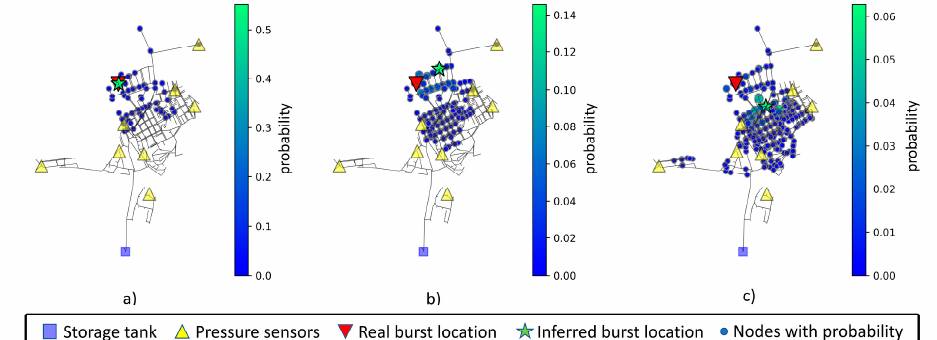
Figure 10. Network prediction areas for node 20, considering ( a ) 0% noise level, ( b ) 1% noise level, and ( c ) 3% noise level. Nodes with higher probability are displayed in a greener color and with lower probability in a bluer color, following the scale presented to the right of each chart.